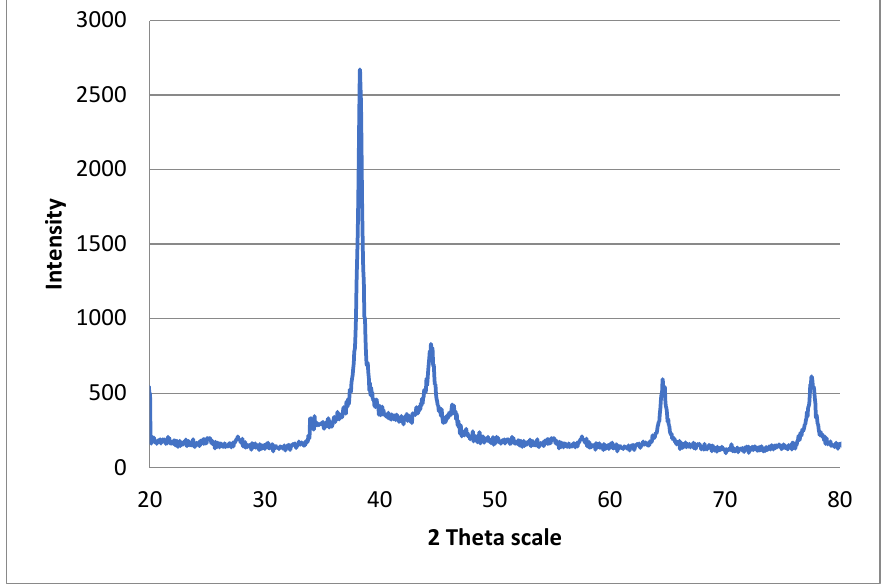
Figure 2. Transmission electron microscopy (TEM) micrograph of AgNPs produced with Ulvan from Ulva lactuca .